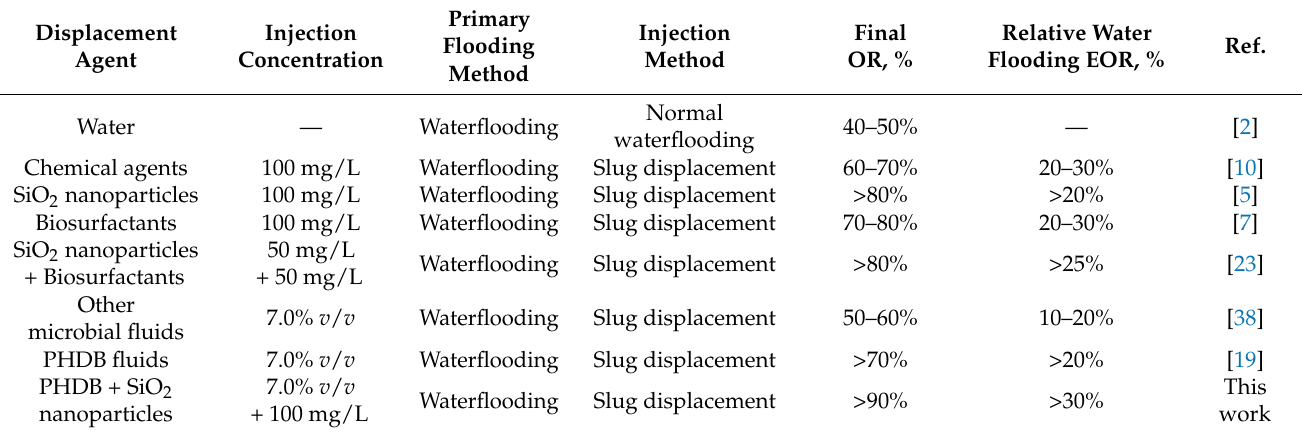
Table 3. Performance of different oil-displacement technologies on crude oil recovery in the low- permeability